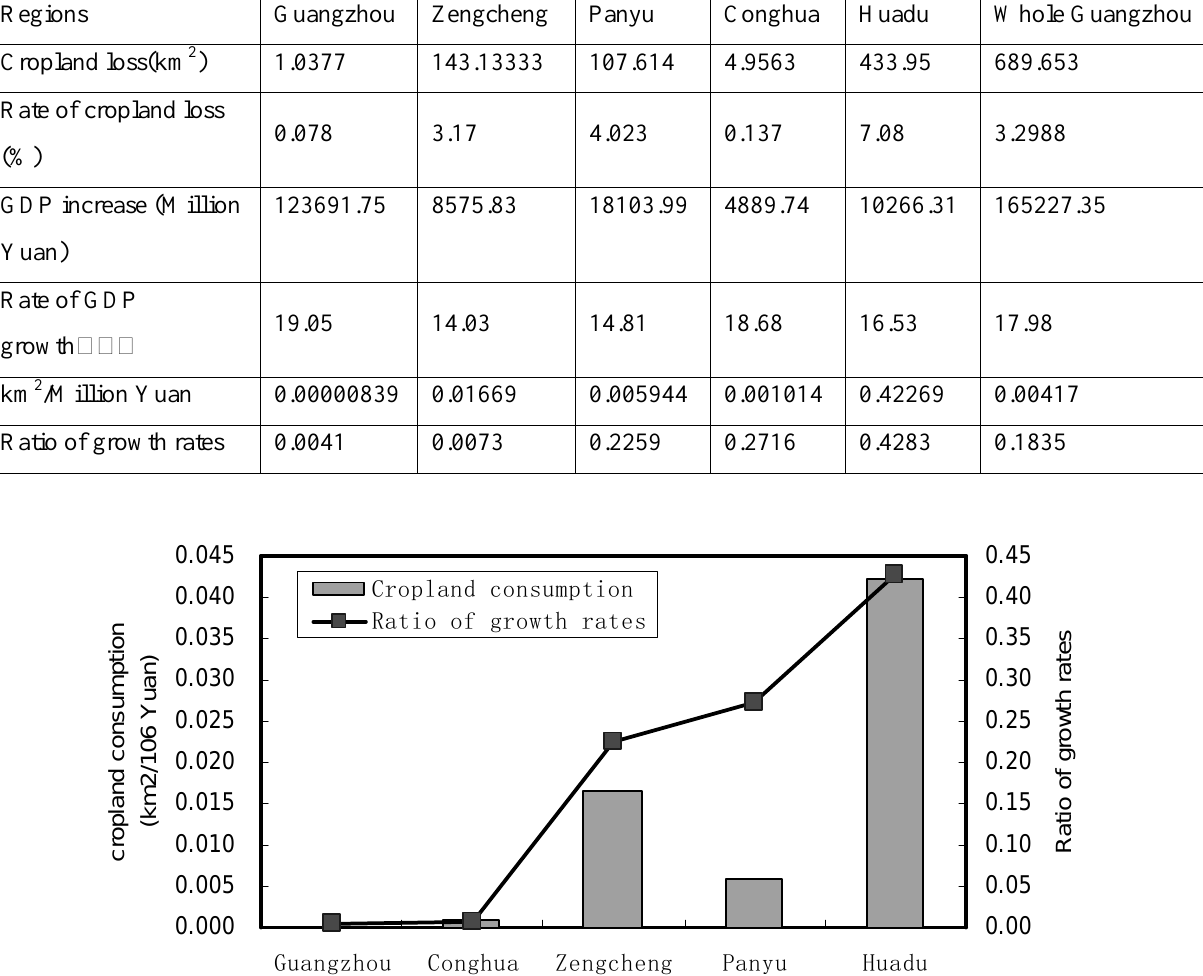
Table 8. The cropland losses of per capital Million Yuan.